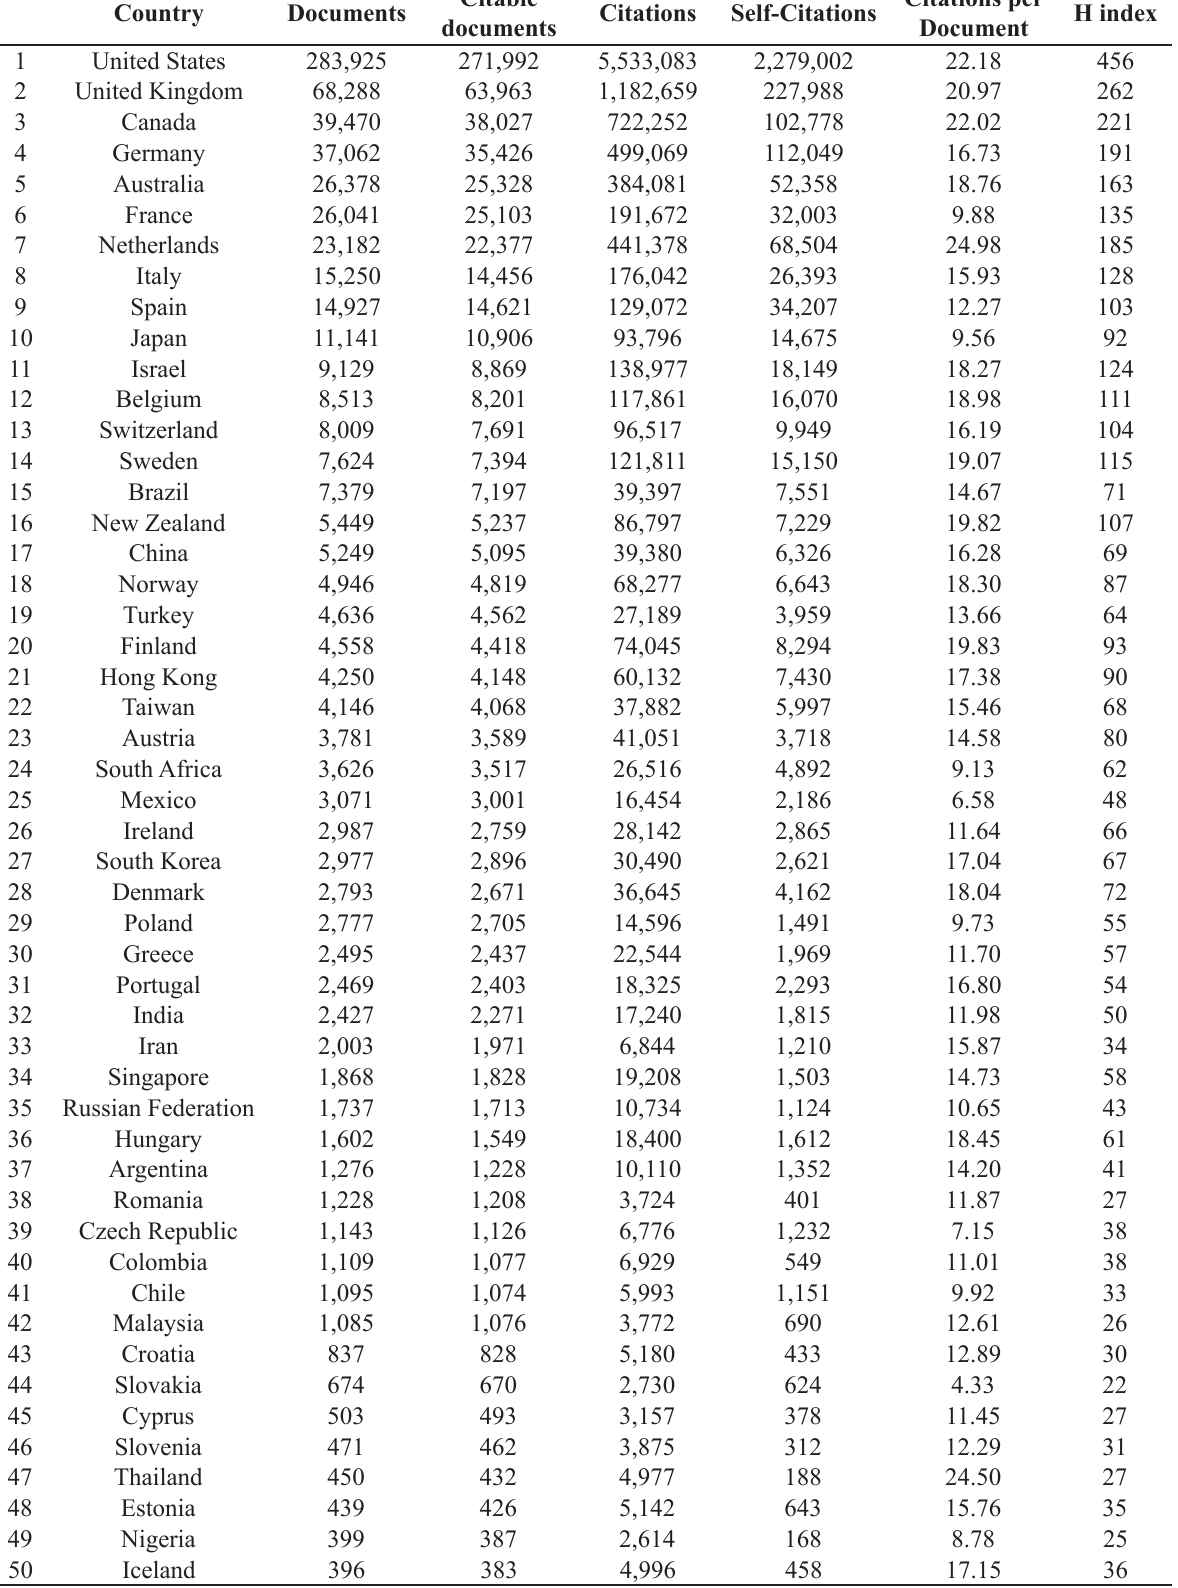
Ranking of Countries in Terms of Production in Psychology for the Period of